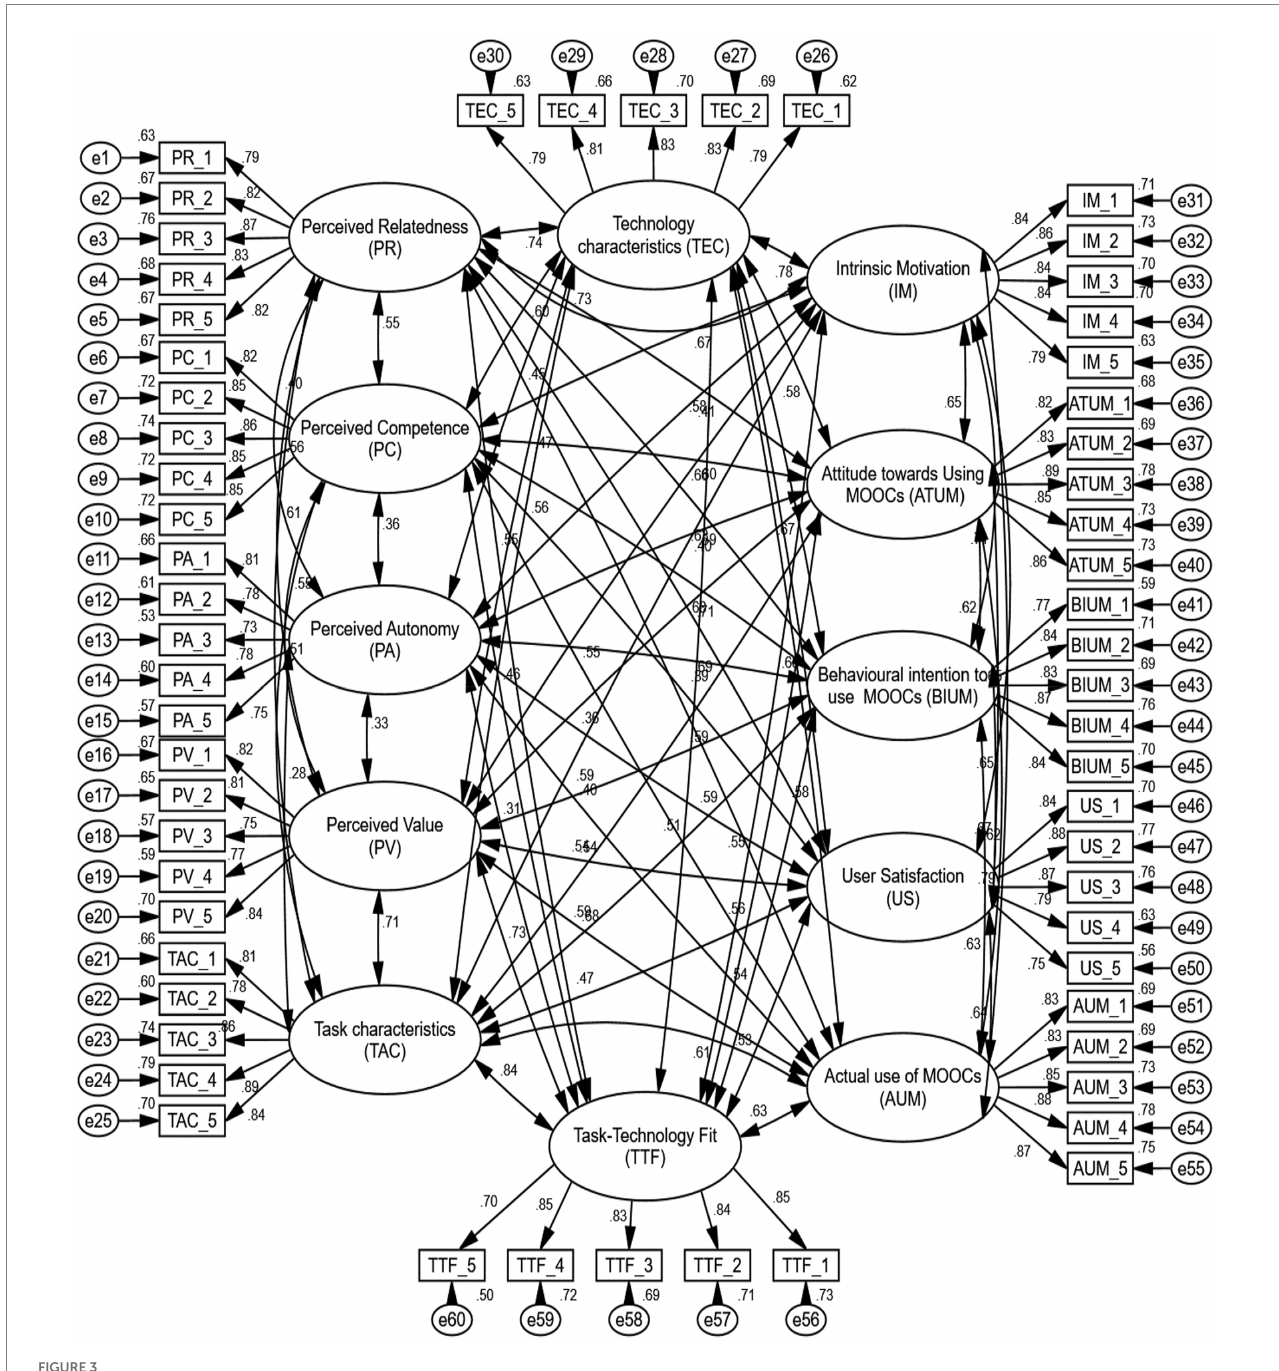
FIGURE 3 Measurement of independent, mediator, and dependent